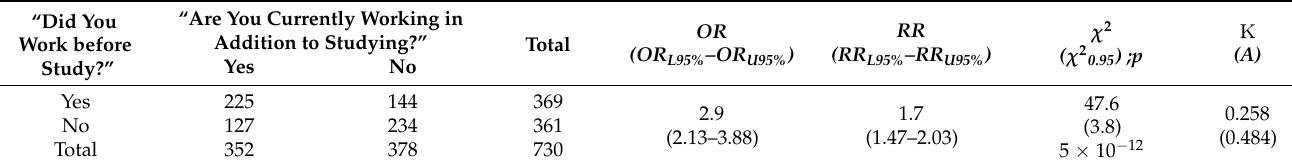
Table 1. Distribution of respondents by answers to the hypothesis that pre-university employment affects employment during study. “Did You Work before